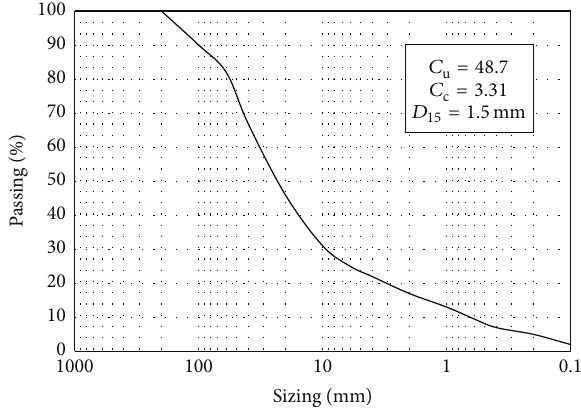
Figure 1: The aerial view of project place. radius, injection pressure, and grouting parameters. Song